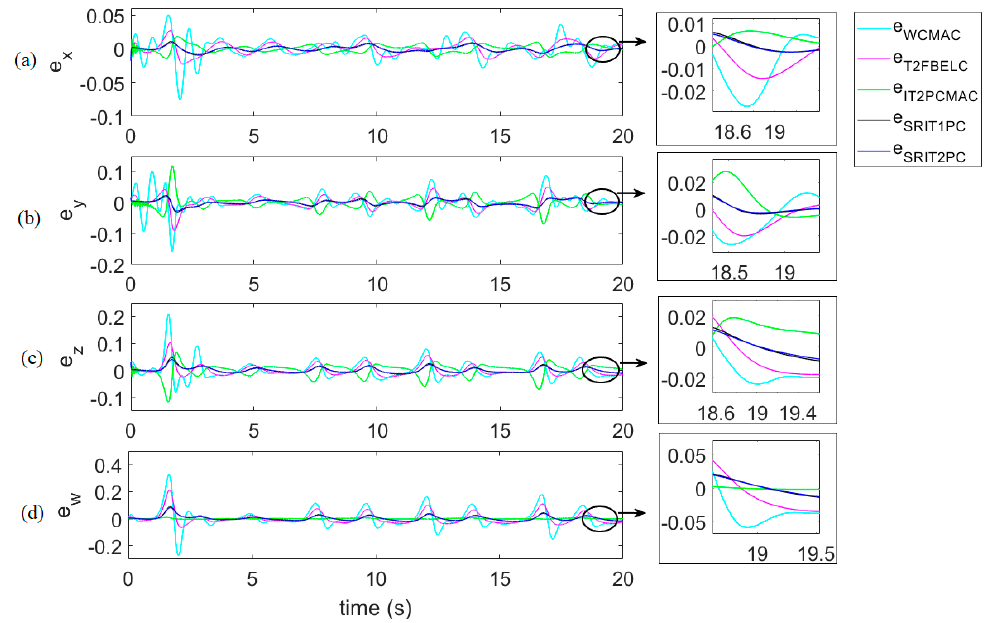
Figure 10. Tracking errors between the proposed SRIT2PC and other synchronization methods for Case 1: ( a ) e x , ( b ) e y , ( c ) e z , and ( d ) e w .